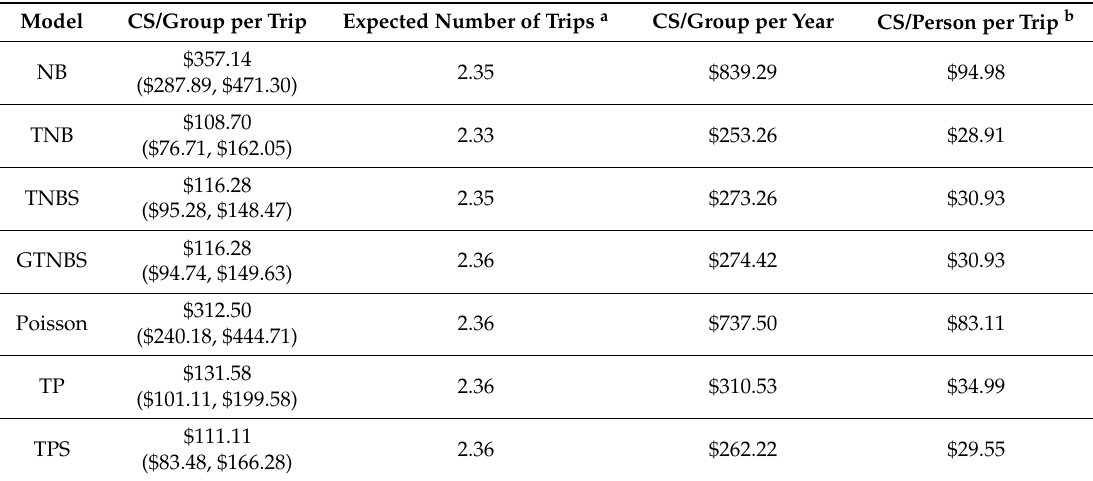
Table 4. Consumer surplus (CS) estimation.